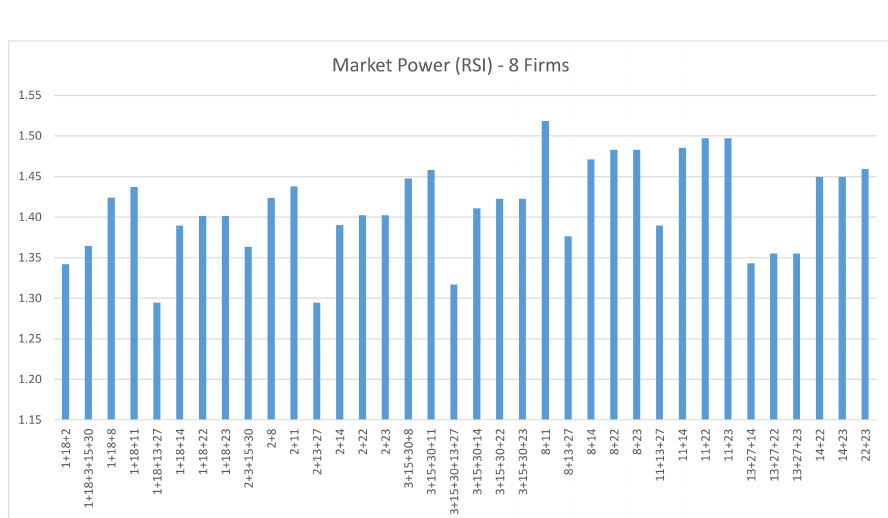
Figure 18. RSI for 8 firms’ setting